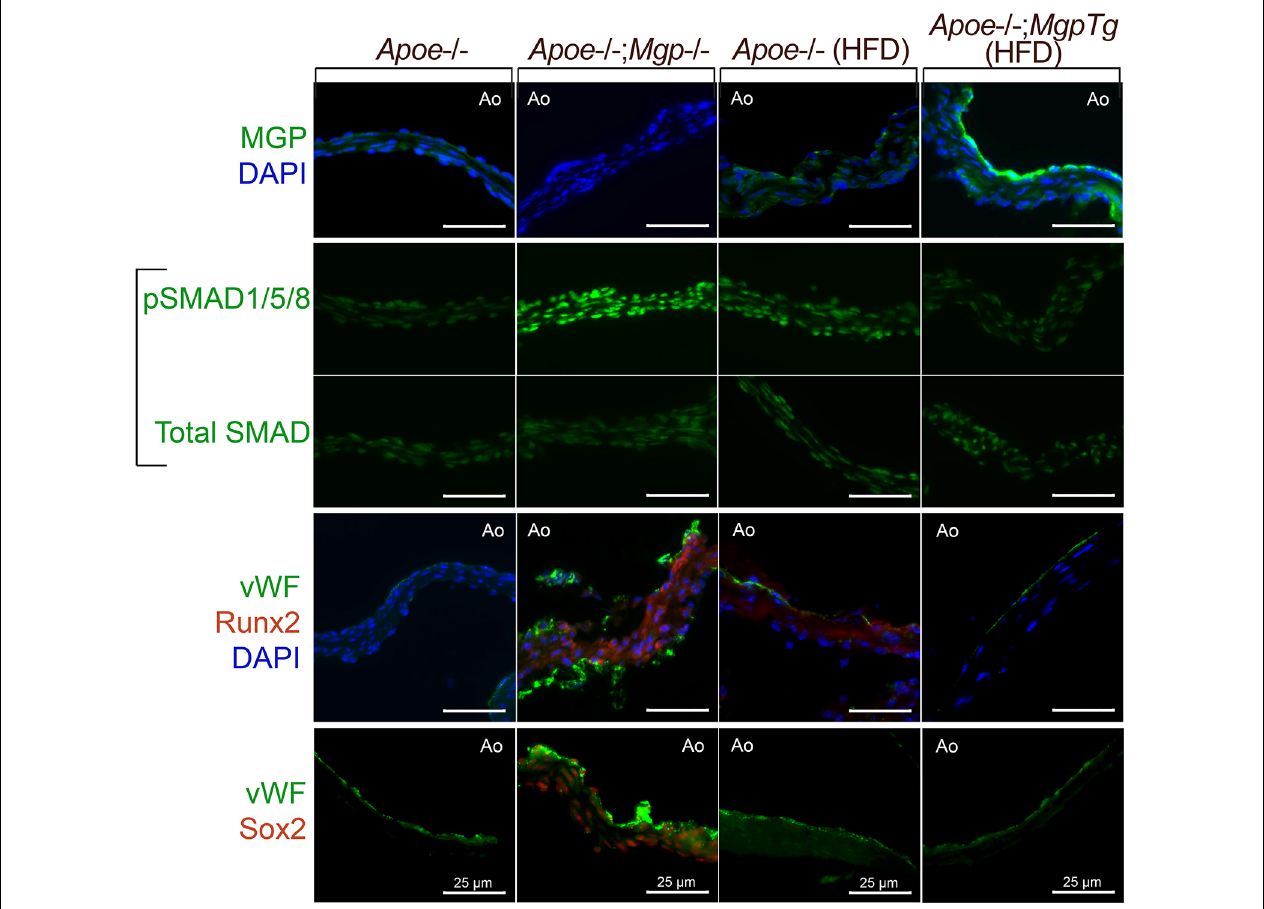
FIGURE 4 | Aortic valves from Apoe − / − mice with loss − or gain-of-function of Mgp. Aortic valves from Apoe − / − and Apoe − / − ; Mgp − / − mice, and from Apoe − / − mice and Apoe − / − ; Mgp tg / wt mice fed a HFD (16 weeks) were stained for MGP, phosphorylated (p)SMAD1/5/8, total SMAD, von Willebrand factor (vWF), Runx2, or Sox2 as indicated. When present, MGP was detected on the aortic side of the valve leaflet. Absence of MGP activated pSMAD1/5/8 and expression of Runx2 and Sox2, whereas excess MGP diminished pSMAD1/5/8, Runx2, and Sox2. Ao; aortic side (always facing up), Tg; transgene All bars are 25 µ m.